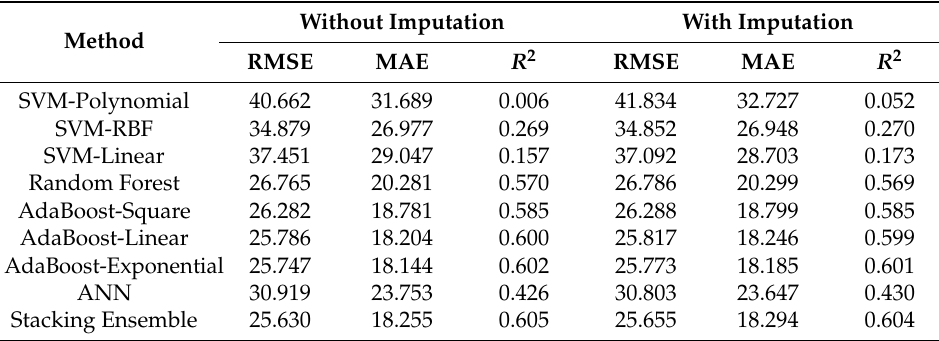
Table 9. Results of ML Algorithms for Changhua F24-AQI